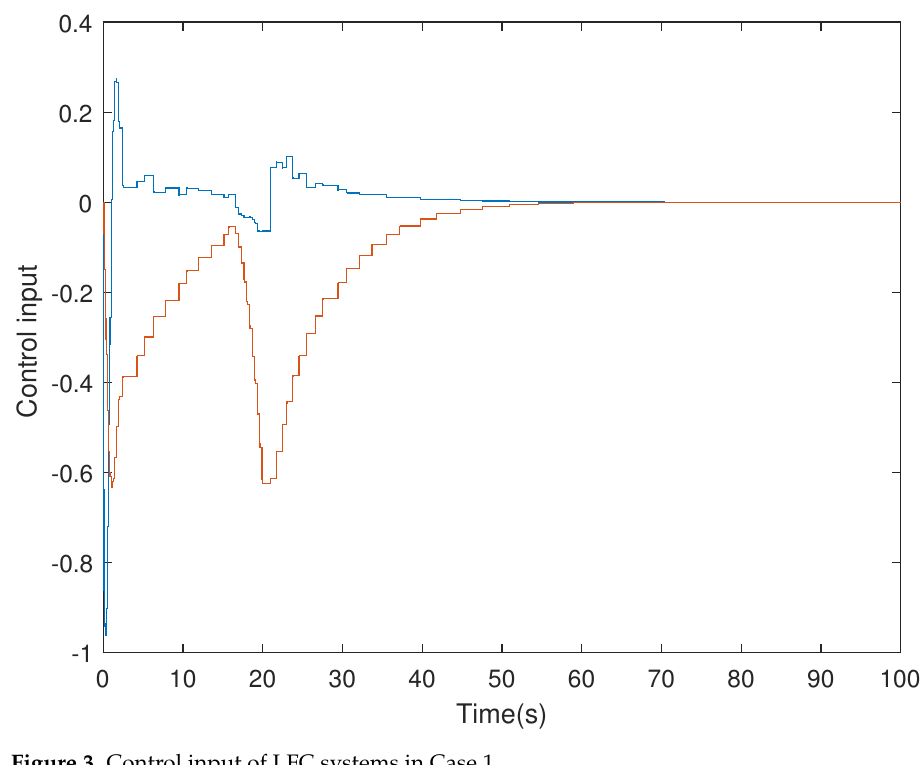
Figure 3. Control input of LFC systems in Case 1.